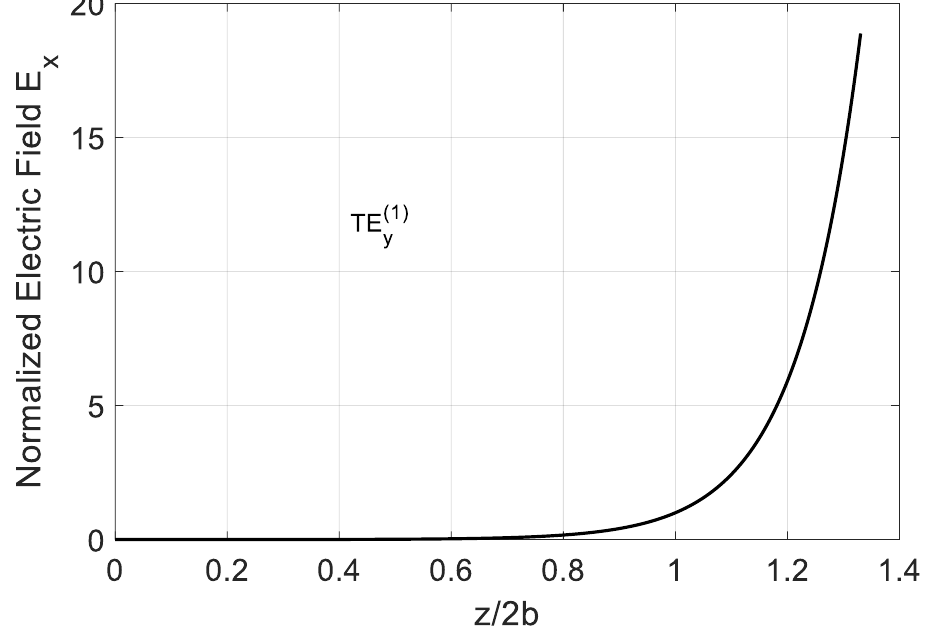
( 1 ) = 0 y backward mode at x g are from Ref. [21]: T = 300 K,